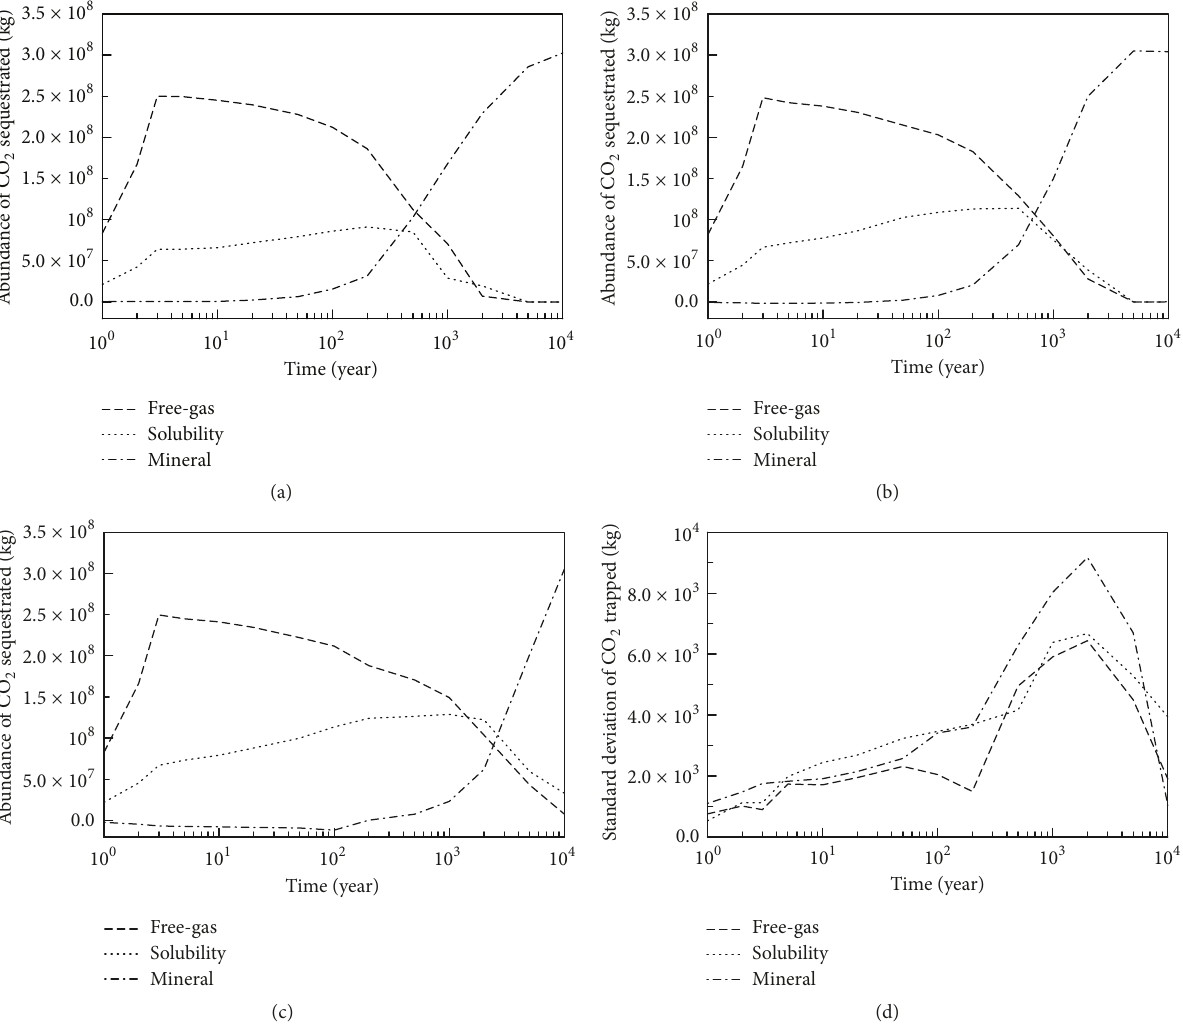
Figure 3: The evolution of the injected CO 2 in different trapping mechanisms for the Liujiagou formation (a), the Shiqianfeng formation (b), and the Shihezi formation (c) and the evolution of standard deviations for different trapping mechanisms (d) over time.